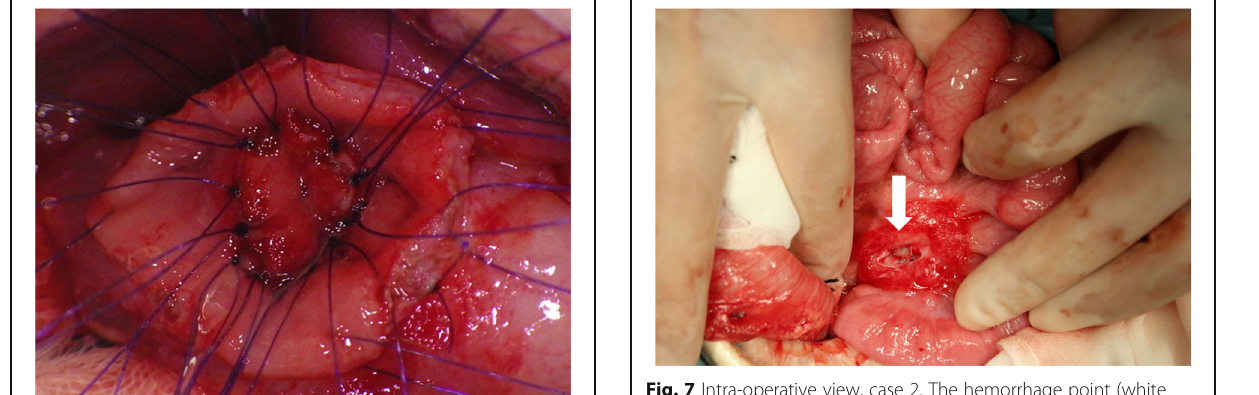
Fig. 7 Intra-operative view, case 2. The hemorrhage point (white arrow) is located on the ileal mesentery. The tissue near the hemorrhage point was biopsied